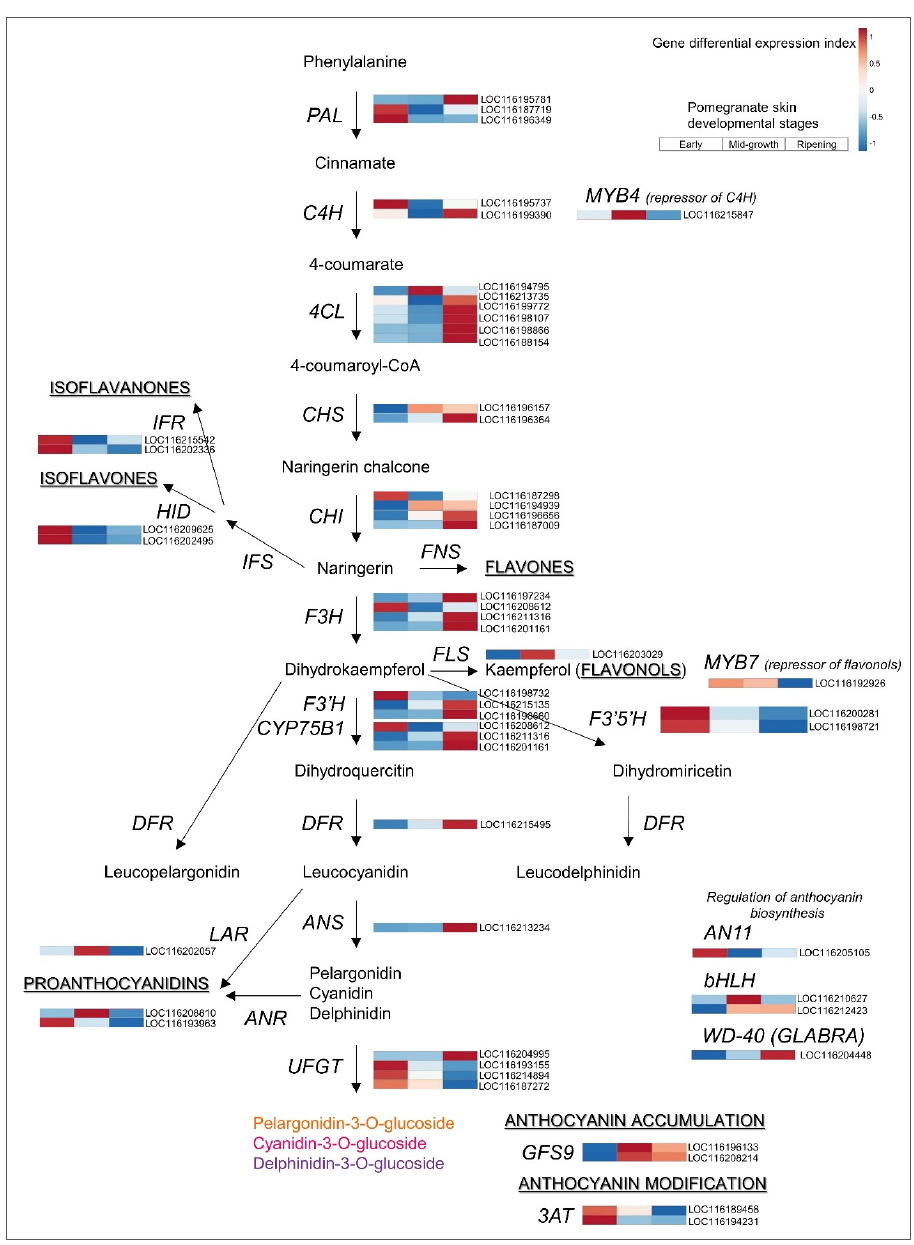
Figure 7. Anthocyanin and flavonoid pathways and regulatory factors in pomegranate skin. See Figure 3 legend for details. Expression level values and full gene names are given in Table S11.